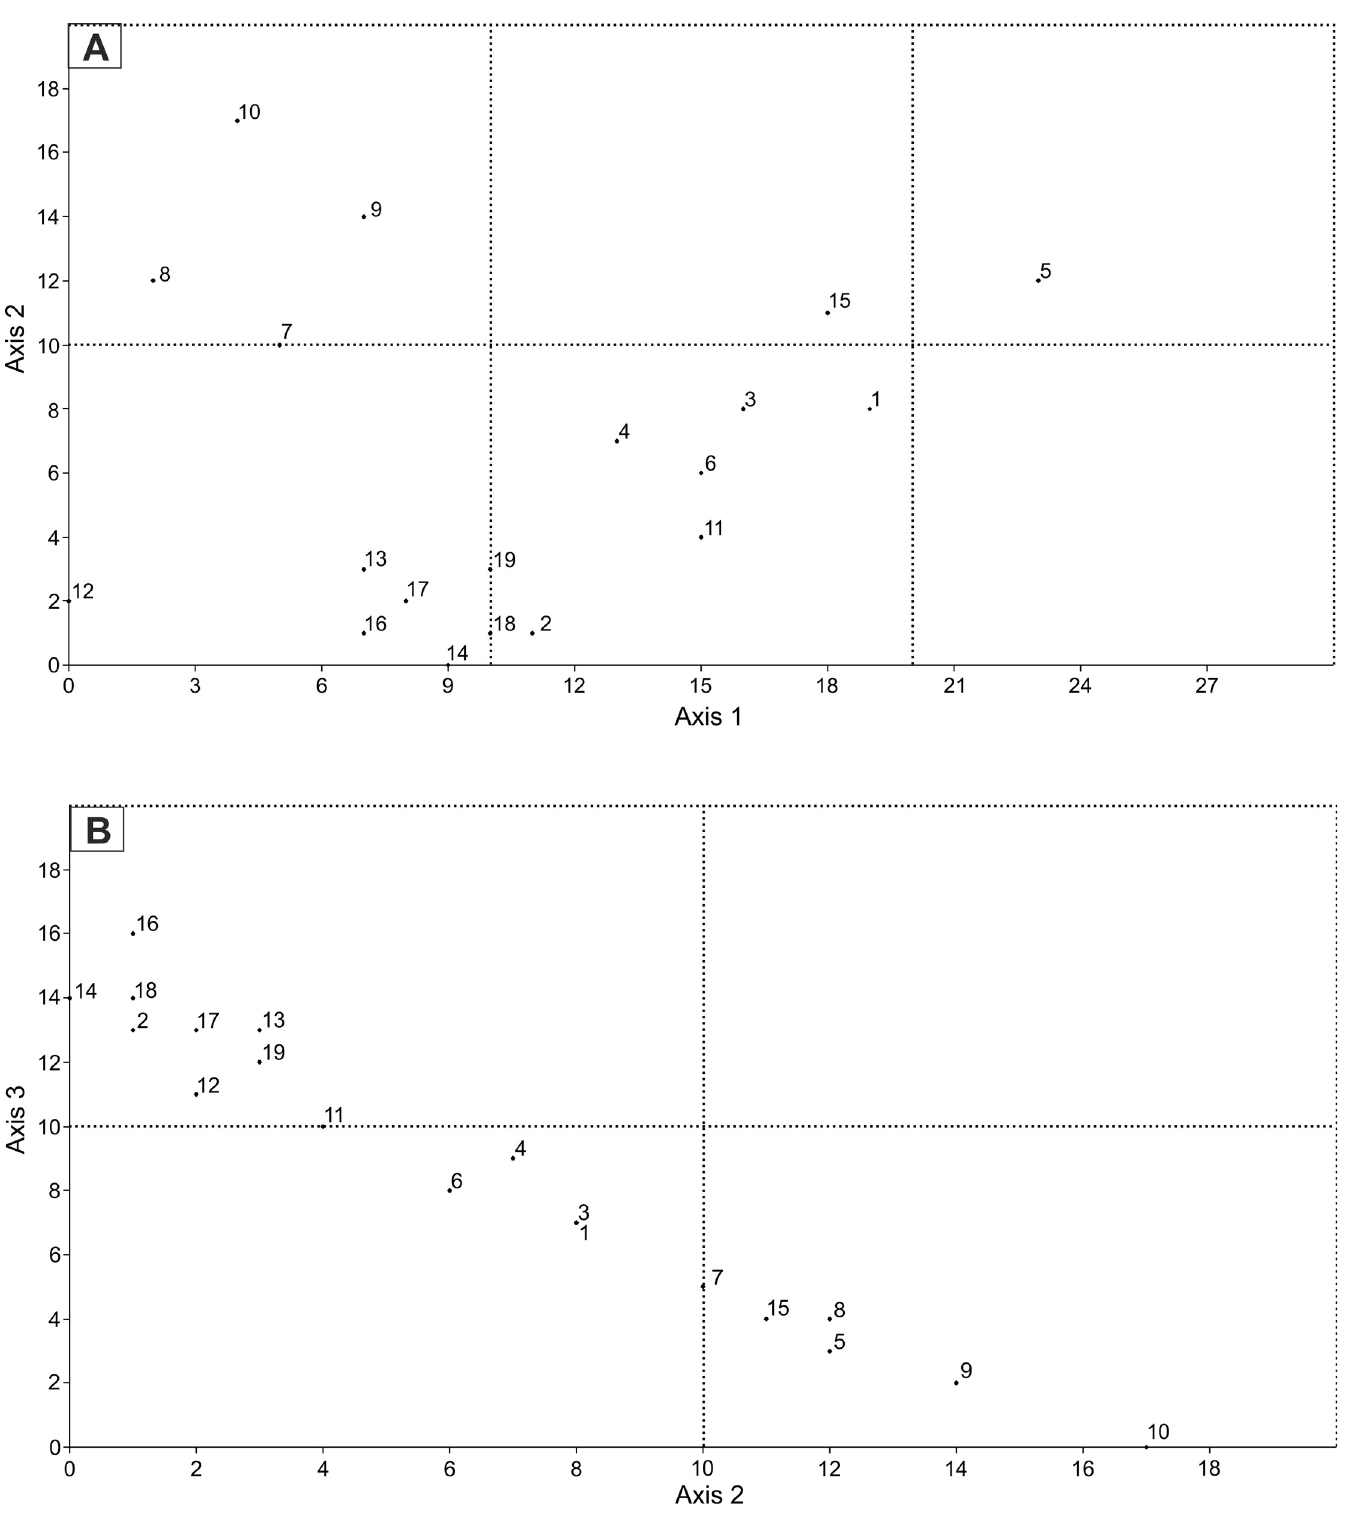
Fig 13. Scatter plot of three groups of specimens (previously distinguished in Table 2) in Canonical Variates Analysis (CVA). A—calculated on the basis of column 3–5 from Table 2, which illustrated measurements of thickness of inner and outer layer in relation to cyst shape coefficient, B–calculated on the basis of column 3–4 from Table 2 which shows that increasing cyst size implies thicker inner and outer layers. 1–6 – Cadosinopsis nowaki , 7–12— C . andrusovi and 13–19—newly defined C . rehakovii